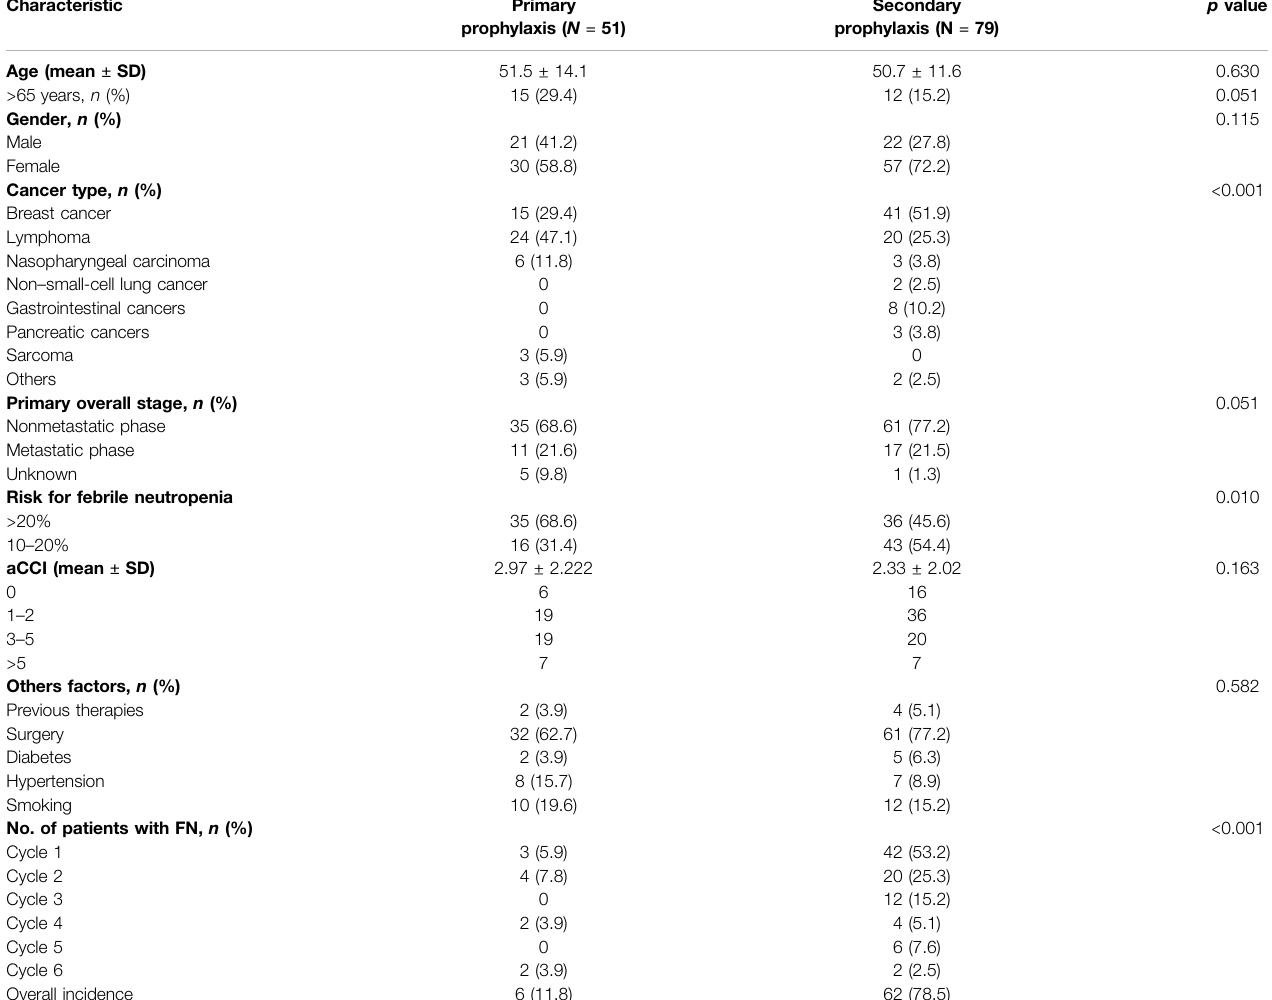
TABLE 2 | Patient characteristics and results of the study.